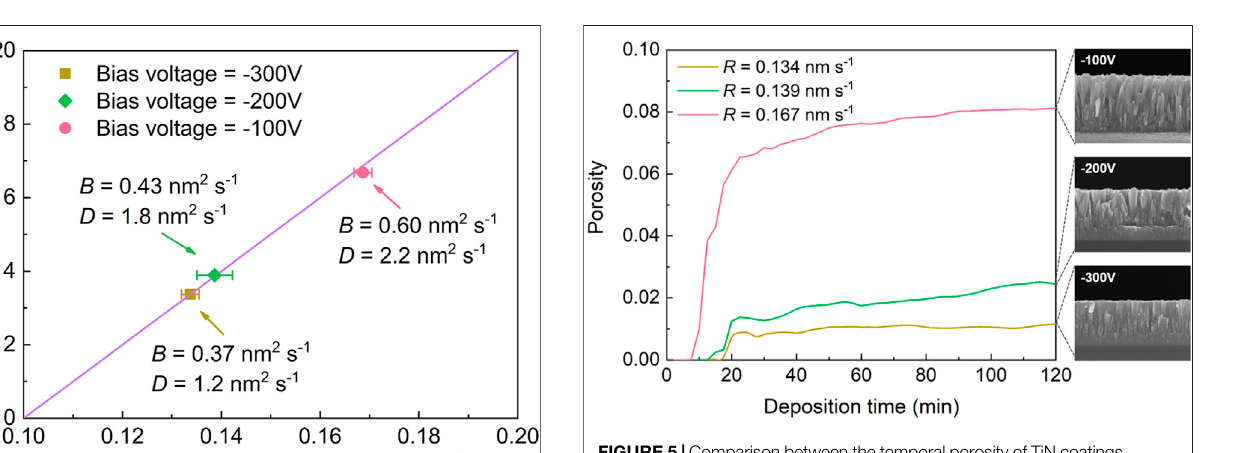
FIGURE 5 | Comparison between the temporal porosity of TiN coatings deposited with different deposition rates (i.e., R ) according to the phase- fi eld simulation for PVD applying different vapor – solid transition velocities (i.e., B ) and diffusion coef fi cient (i.e., D ) and the experimental cross-section images of TiN coatings for qualitative porosity analysis with various bias voltages (Wang et al., 2015). (The images of experimental results are reproduced and presented with premission from